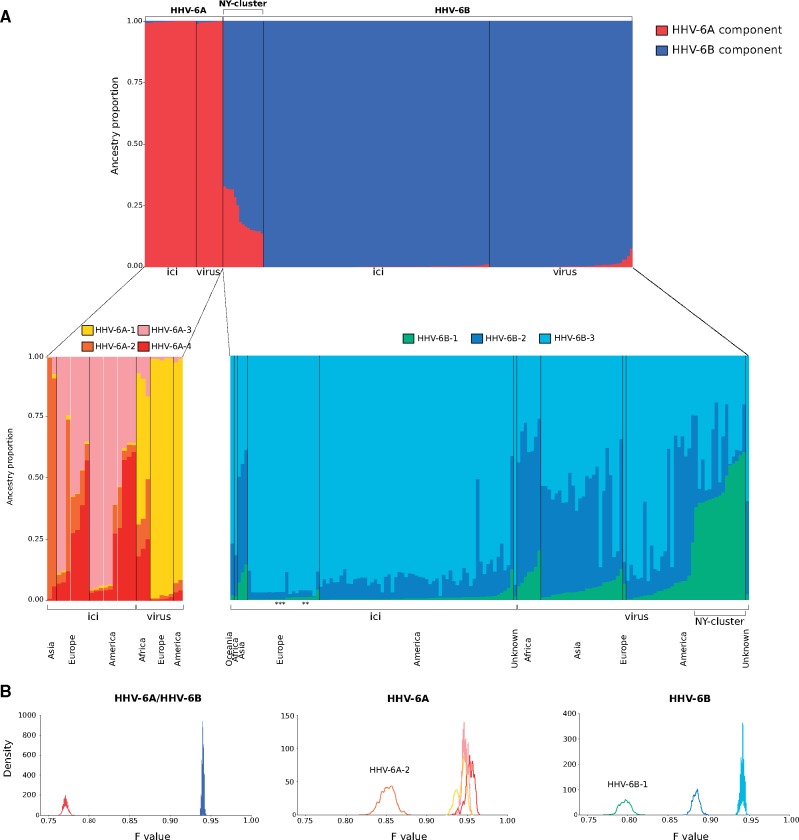
HHV-6 population structure. (A) Bar plot representing the proportion of ancestral population components from the STRUCTURE linkage model for HHV-6, HHV-6A, and HHV-6B. Each vertical line represents a HHV-6 genome. Samples are ordered on the basis of their integration/exogenous status, of viral species classification, and of geographic origin. Stars indicate European iciHHV-6B sequences deriving from the same integration event (Zhang et al. 2017). (B) Distributions of posterior F values for the ancestral populations. Colors are as in panel (A).